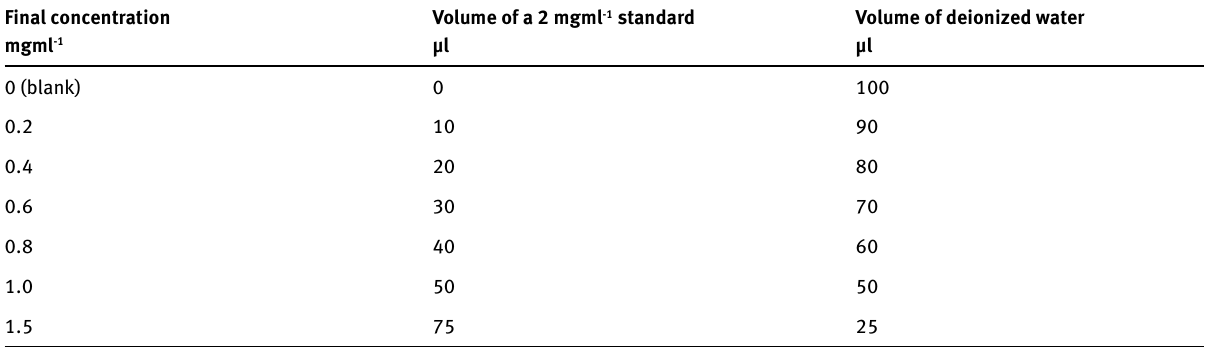
Table 2: Standard dilutions for preparation of a calibration curve Final